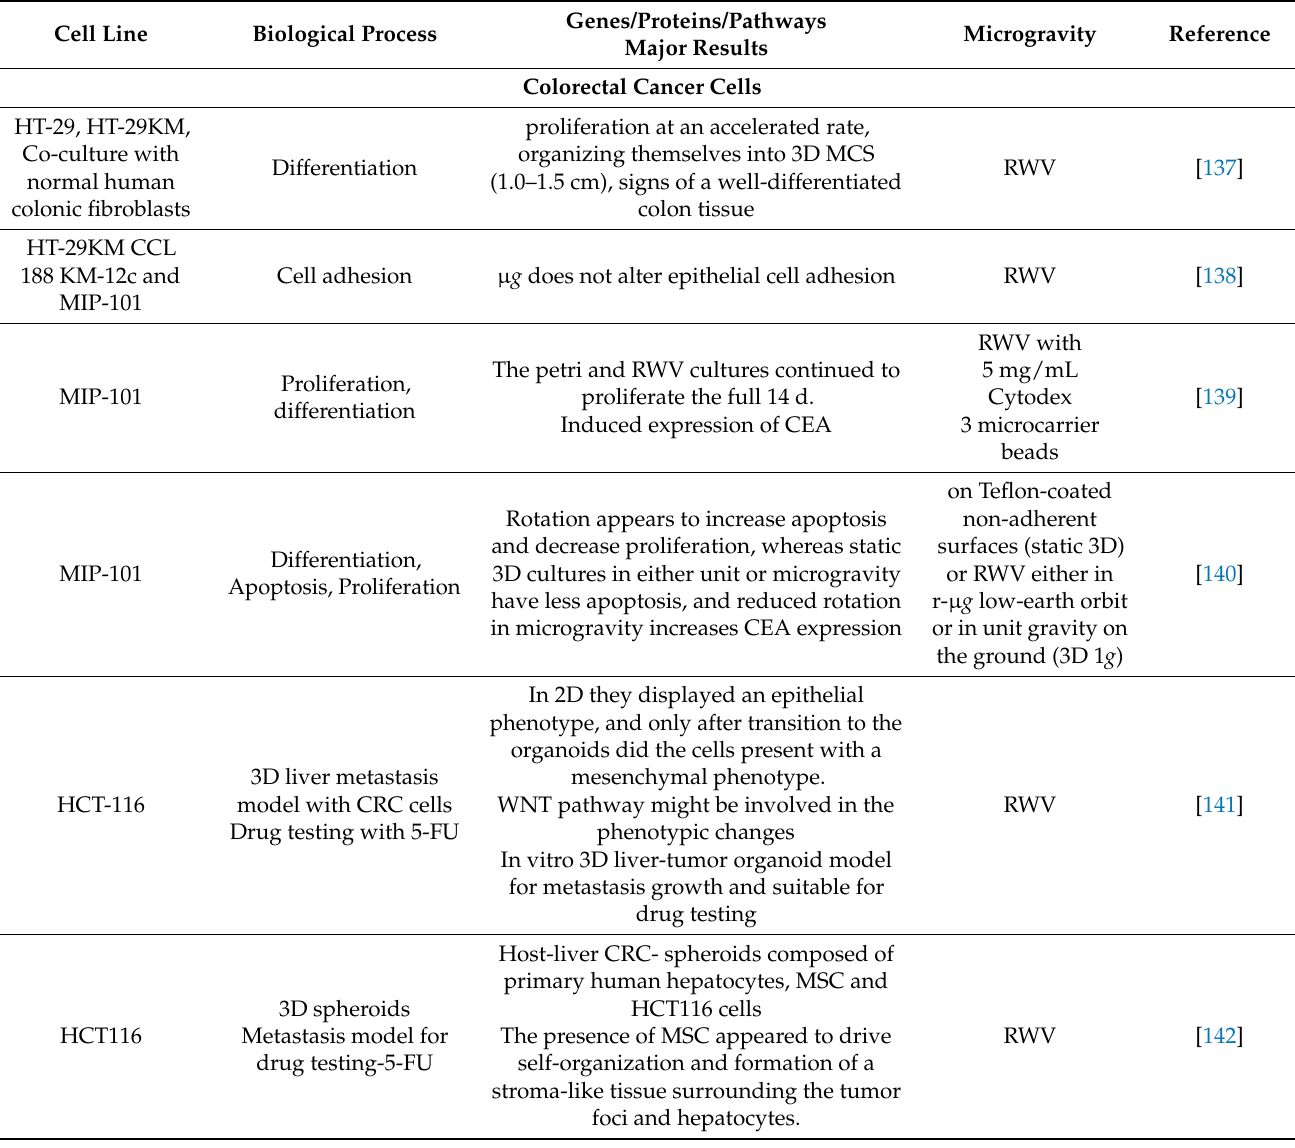
Table 4. Overview of results of studies with gastrointestinal cancers exposed to µ g